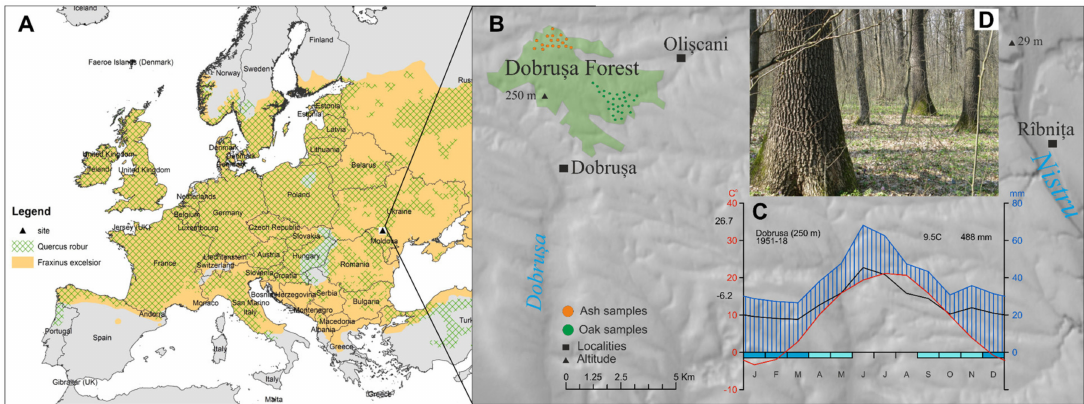
Figure 1. Site location. ( A ) ash ( Fraxinus excelsior ) and oak ( Quercus robur ) distribution in Europe; ( B ) sampling site; ( C ) Walter–Lieth climatic diagram for Rîbnit divided by 2 and the black line represents precipitation divided by 3; red line: temperature; blue bars: the appearance of daily minimum negative temperatures), ( D ) image from Dobrus